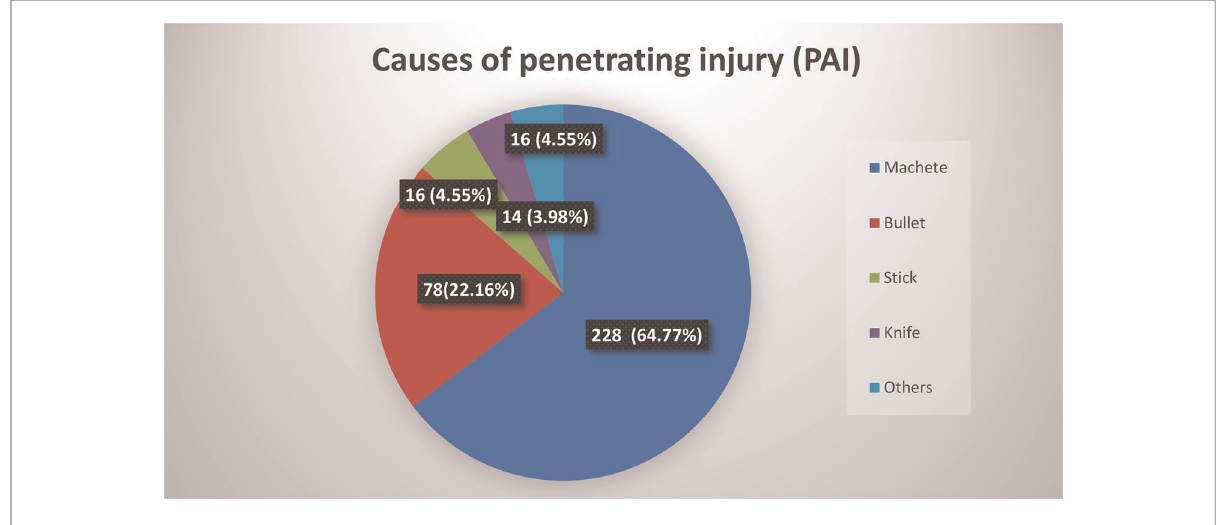
FIGURE 1 Causes of injury in the study to assess the treatment outcome and pattern of penetrating abdominal trauma victims who underwent surgical exploratory laparotomy during 2015 – 2019 at HFSUH.